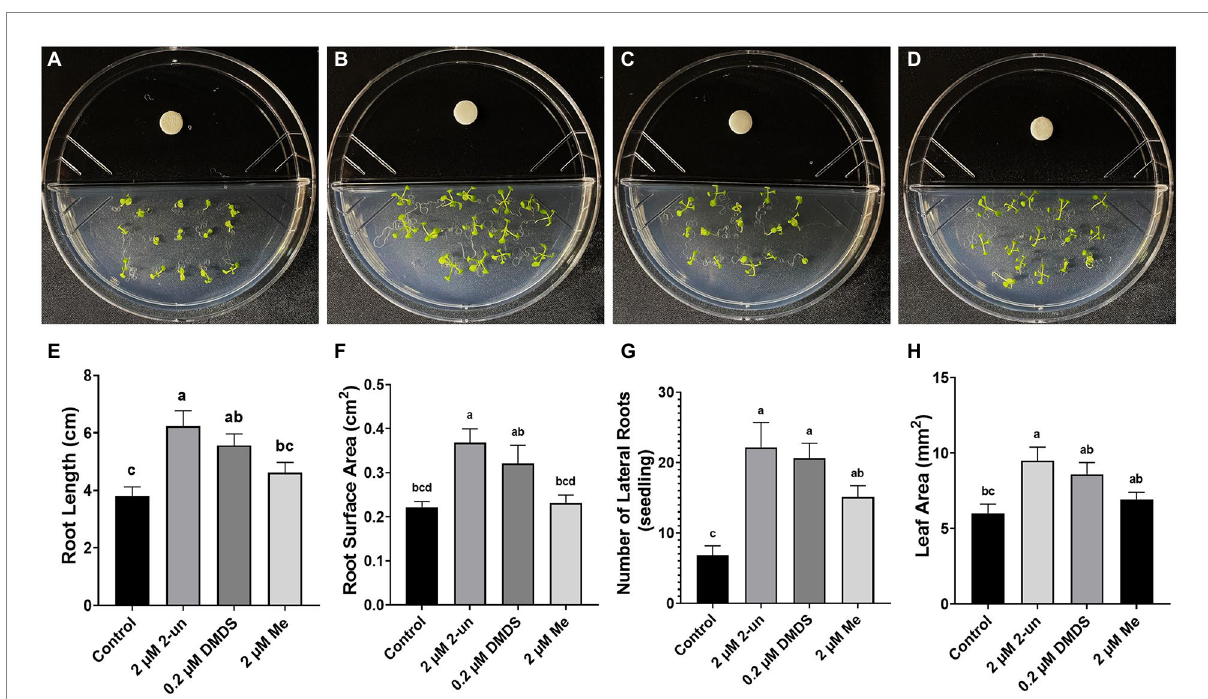
FIGURE 7 Effect of pure synthetic compounds on A. thaliana seedling growth after 10 days under no-stress conditions. Representative photographs of (A) control seedlings and seedlings treated with (B) 2 μ M 2-undecanone, (C) 0.2 μ M dimethyl disulfide, (D) 2 μ M methyl thioacetate. (E–H) Growth parameters of representative A. thaliana seedlings including (E) root length, (F) root surface area, (G) lateral root numbers, and (H) total leaf area. Error bars represent SEM of three independent biological replicates ( n = 20 seedlings per replicate). Different letters indicate significant differences between treatments (one-way ANOVA followed by Tukey’s test; p <